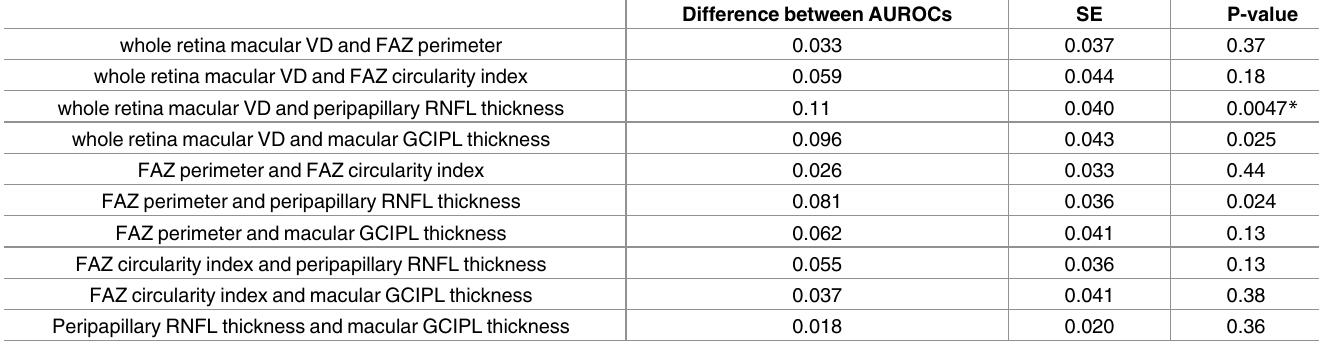
Table 5. Pairwise comparisons of AUROC curves referring to the glaucoma group.